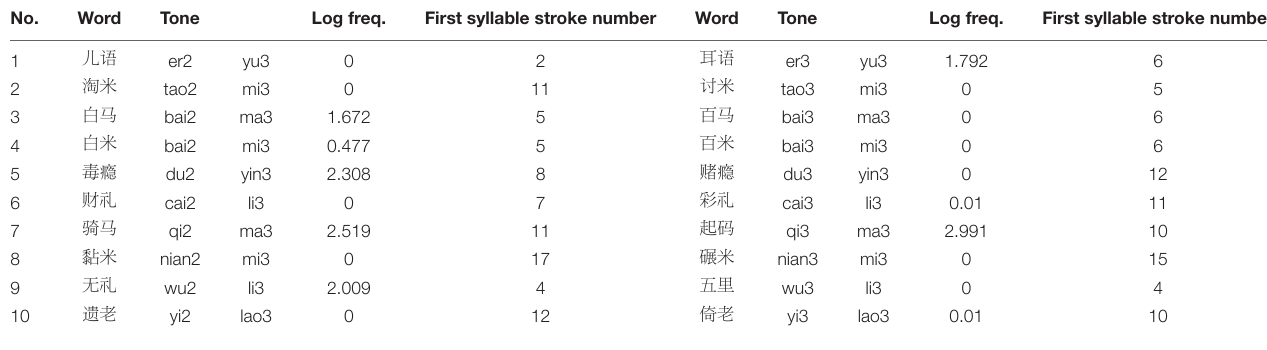
TABLE A1 | The critical